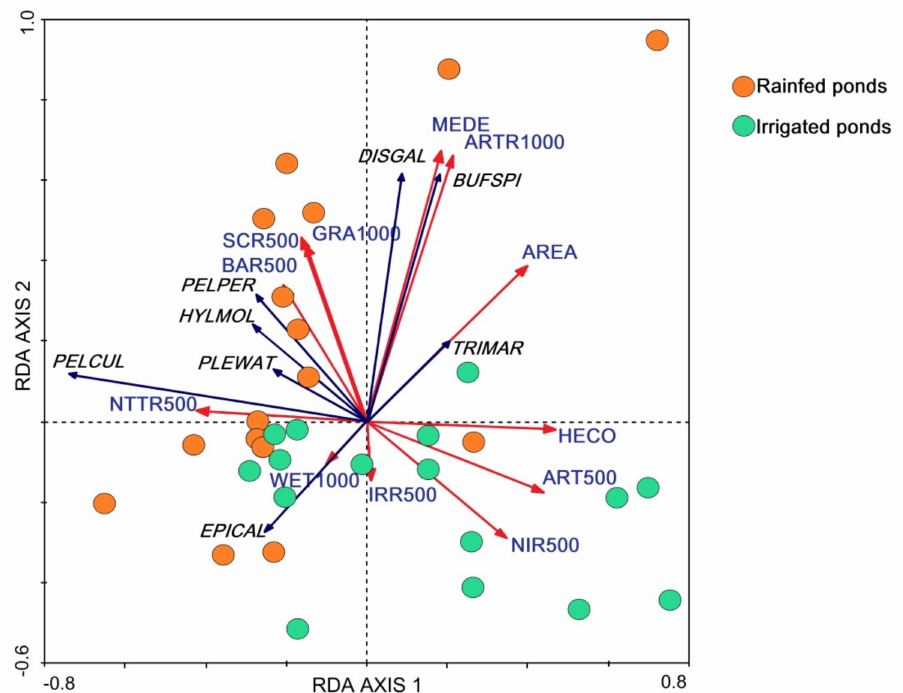
Figure 5. RDA ordination plot showing the main two redundancy axes and their relationships with local and landscape environmental variables (red arrows) and patterns of amphibian species occur- rence (blue arrows). PLEWAT: Pleurodeles waltl ; TRIMAR: Triturus marmoratus ; PELCUL: Pelobates cultripes ; DISGAL: Discoglossus galganoi ; BUFSPI: Bufo spinosus ; EPICAL: Epidalea calamita ; HYLMOL: Hyla molleri ; PELPER: Pelophylax perezi . Environmental variables at the local scale: pond area in m 2 (AREA); medium pond depth (MEDE); helophyte cover in % pond area (HECO). Landscape variables in % cover at a 1000 m scale from the pond: man-made forest, poplar or pine (ARTR1000); grasslands (GRA1000); wetlands (WET1000). In % cover at a 500 m scale from the pond: natural oak forest (NTTR500), artificial surfaces (ART500), bare ground (BAR500), scrub